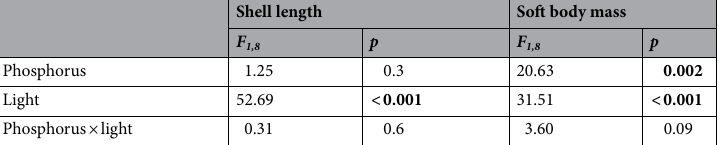
have constrained rather than stimulated the growth of A. fluviatilis soft body mass. Alternatively, snails might have invested the excess phosphorus into reproduction rather than growth. However, for technical reasons, we were not able to properly quantity snail reproduction rates, thus mechanisms of phosphorus allocation in A. fluviatilis growth versus reproduction require further investigation.